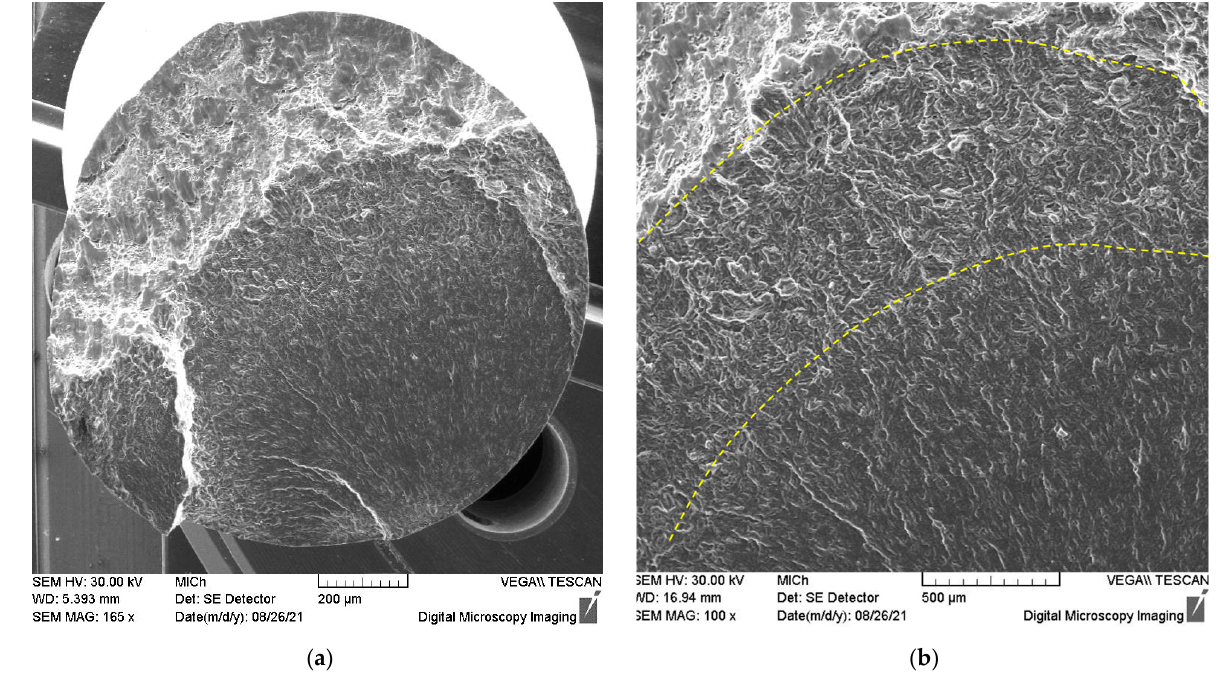
Figure 13. Overall SEM view of the fracture surface ( a ): the transition region on the fracture surface is delineated by the yellow lines ( b ).